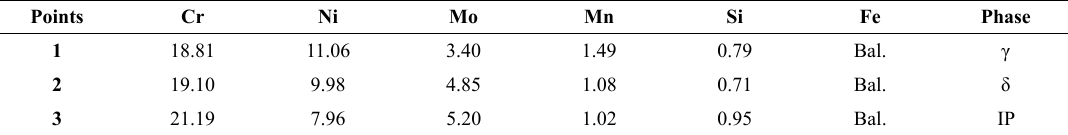
Table 8. Semi-quantitative chemical analysis determined by EDS of points identified by arrows in Figure 4(b) (wt%). Points